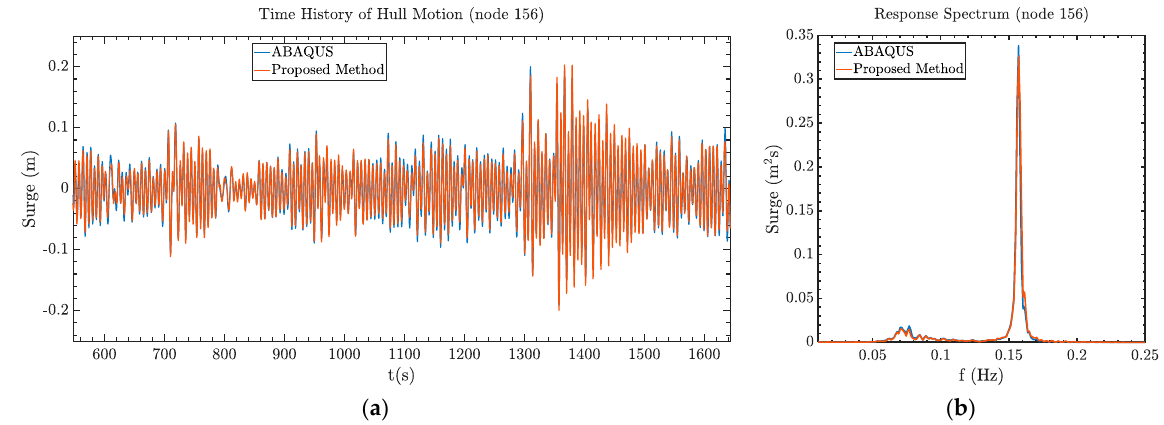
Figure 11. Comparison of motion time history ( a ) and the corresponding response spectrum ( b ) at the hull centroid in surge under irregular wave excitations.